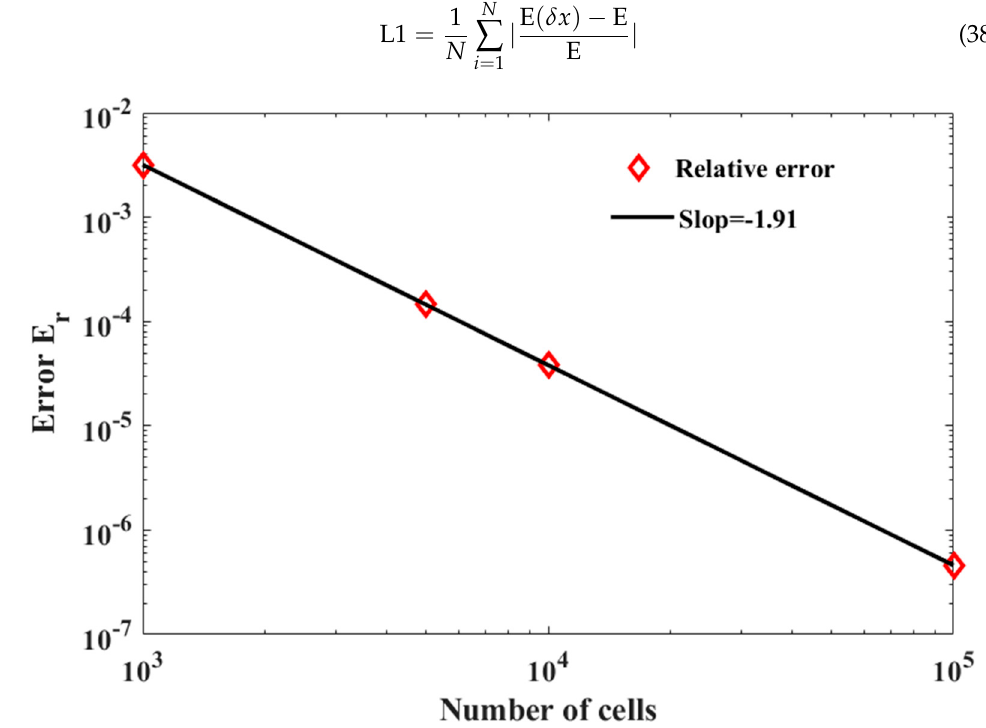
Figure 7. Numerical error as a function of the number of grid points.